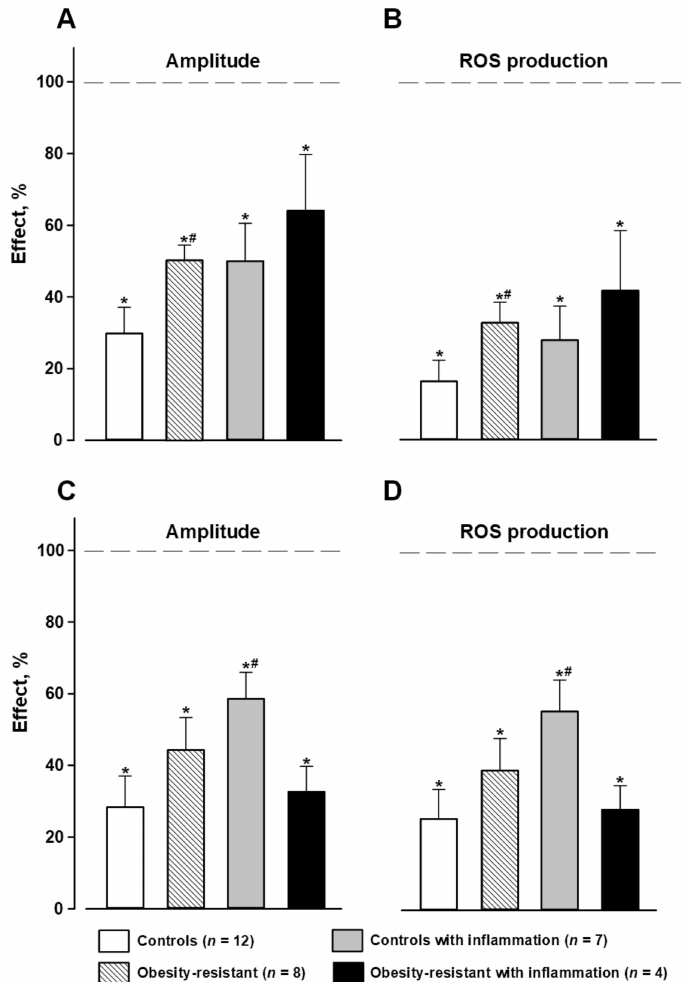
Figure 4. The effects of the inhibitor of PKC on the FPR-mediated respiratory response in murine bone marrow granulocytes. Amplitude and production of reactive oxygen species occurred (ROS) in response to 1 µ M fMLF ( A , B ) and 1 µ M WKYMVM ( C , D ). GF109203X (1 µ M) was used to inhibit PKC. Data are presented as mean ± SEM. Significant differences of parameters are indicated as